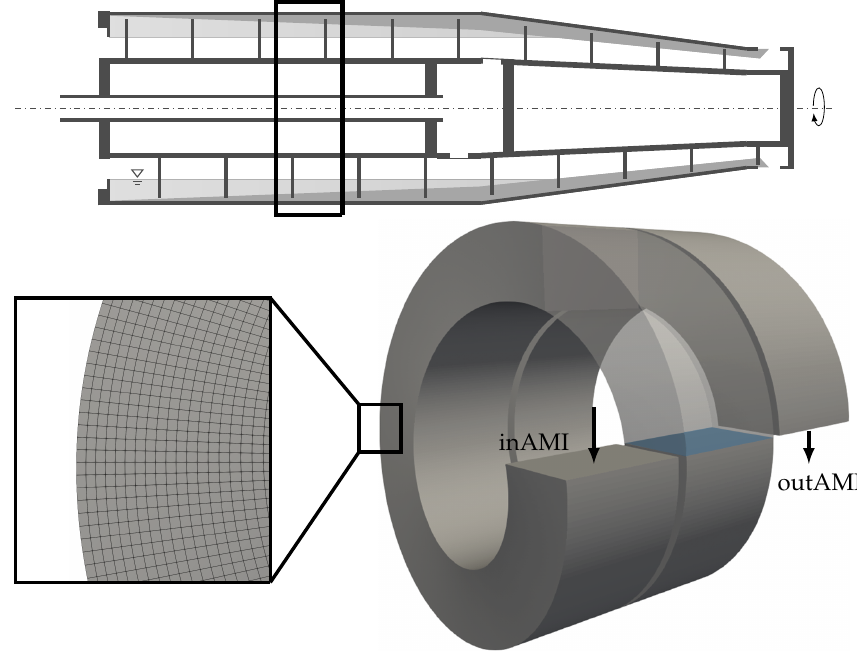
Figure 7. Simplified geometry of a decanter centrifuge and the used mesh. The geometry is a segment of the cylindrical part of the apparatus. The mesh is structured. The area highlighted in blue marks the position of the